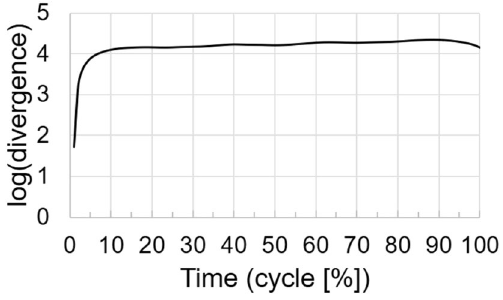
Figure 1. Divergence curve (mean across participants of the middle of the 15-min